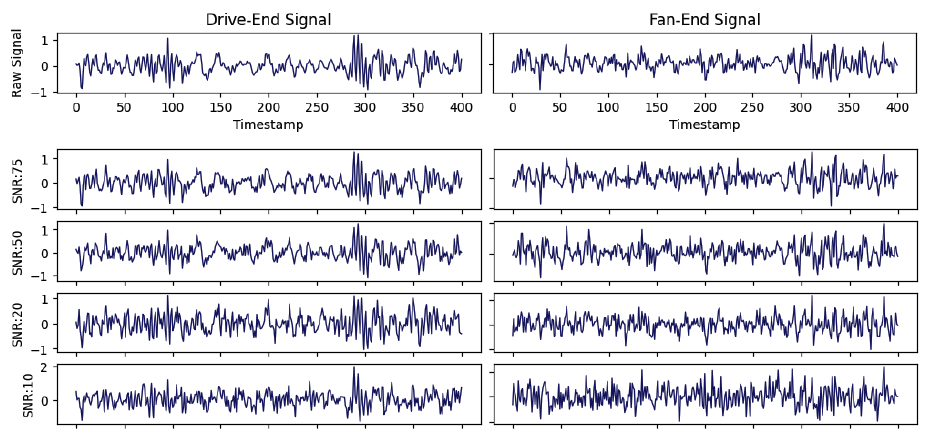
Figure 7. Some noisy signal samples generated from raw sensory data with different